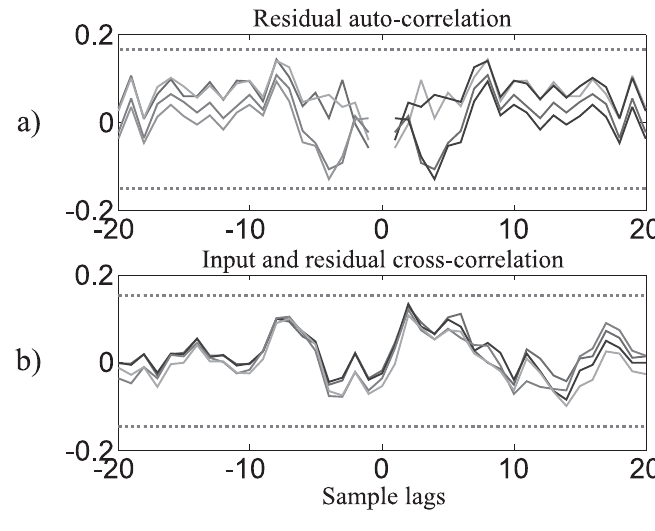
Figure 7. Residual auto– and cross–correlation examples ( K = 4